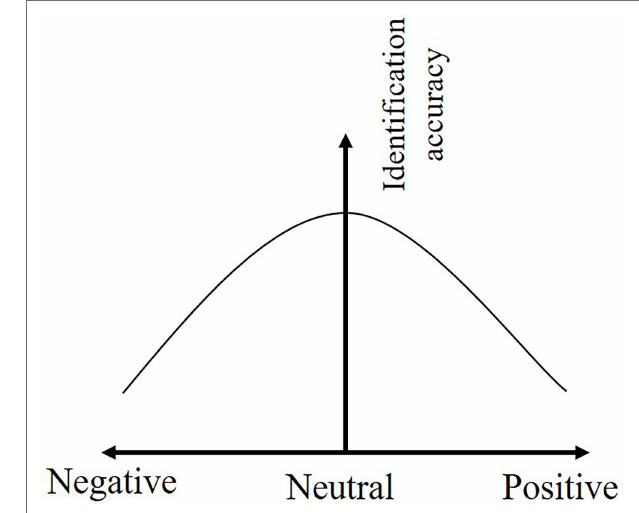
FIGURE 9 | The effect of emotional valence on the reaction time to safety hazard.